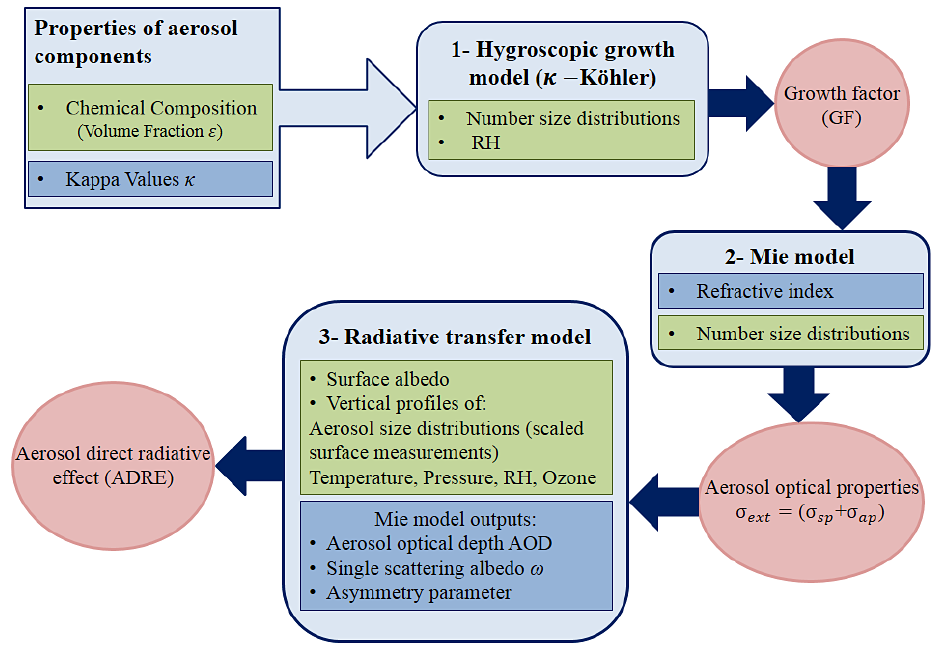
Figure 2. Scheme of the models and their required input, starting with the hygroscopic growth model and ending with the radiative transfer model to calculate the ADRE. The light blue boxes refer to the different model calculations, the green boxes to experimental input data, the dark blue boxes to additional input data (e.g., from literature), and the red circles denote model output. Table 2. The Dry and Wet base cases used in the model calculations. Please note that some of the individual chemical components are available on a monthly basis only (see text for